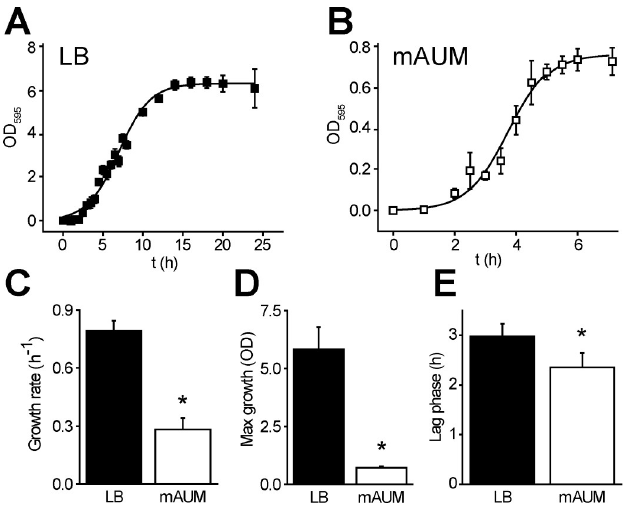
Fig 2. P . aeruginosa growth in LB and mAUM. P . aeruginosa growth curves in LB (A) and mAUM (B) media. Comparison of growth parameters between LB and mAUM: growth rate (C), maximum growth (D) and lag phase (E). These parameters were calculated using Eq 1. Results are expressed as mean ± S.D. n � 5. � , p < 0.01 after t